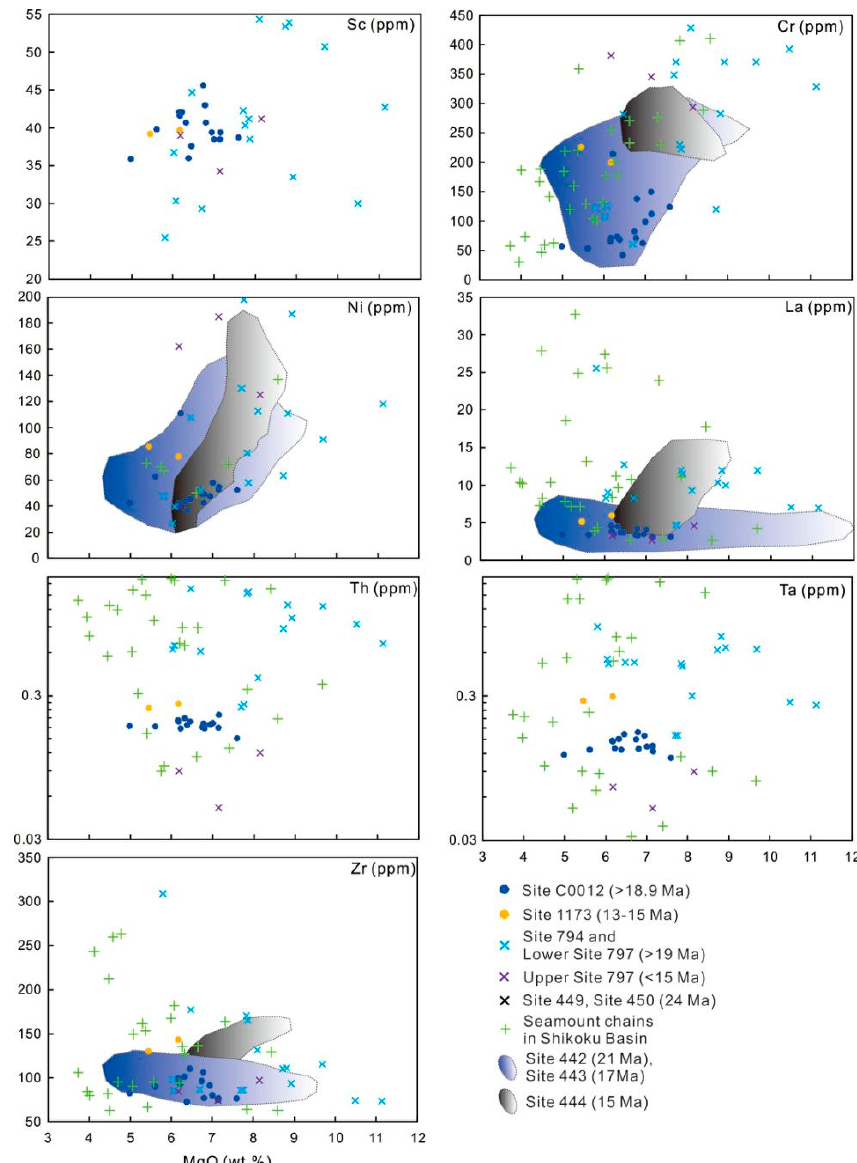
Figure 8. MgO versus trace elements of Cenozoic volcanic rocks from the Shikoku Basin. Data sources as for Figure 6.